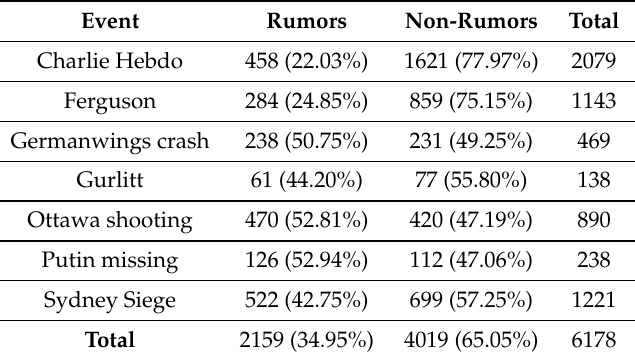
Table 3. Distribution of the PHEME dataset with seven